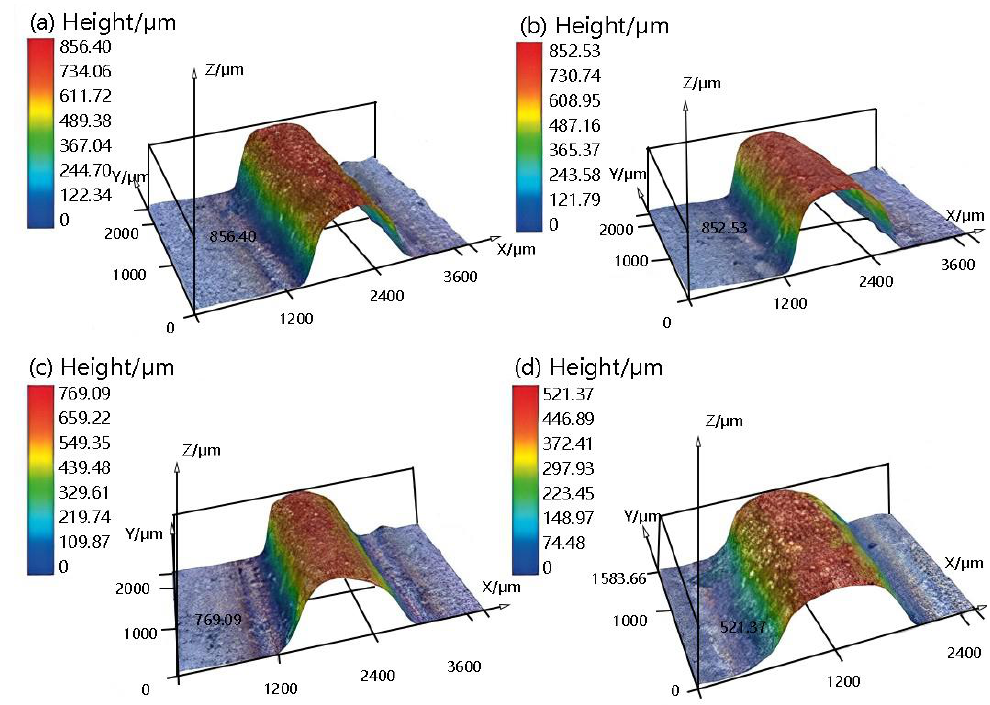
Figure 5. Morphology measurement of deposition layer at different powder feeding rates. ( a ) 16.8 g/min; ( b ) 14.4 g/min; ( c ) 12.0 g/min; ( d ) 9.6 g/min.